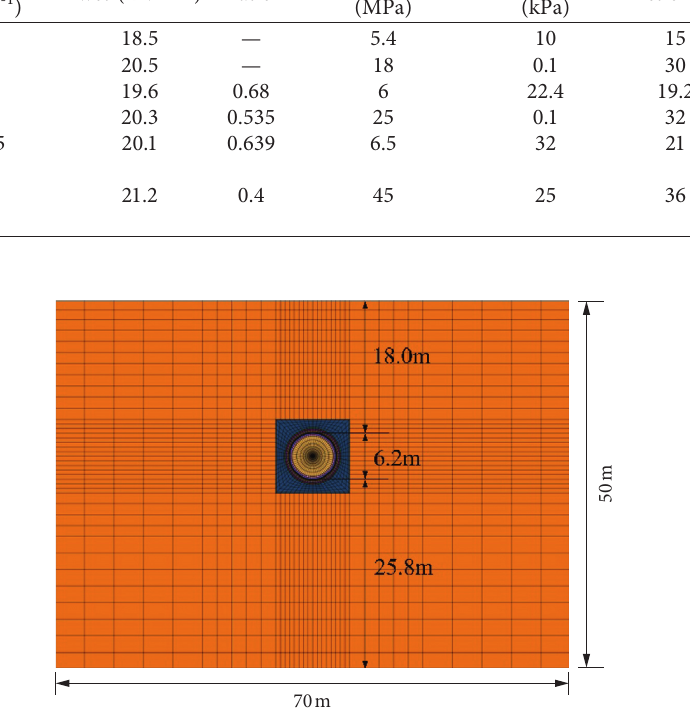
Figure 5: Calculation model. Table 9: Stratum stress release coefficient at each stage of construction.